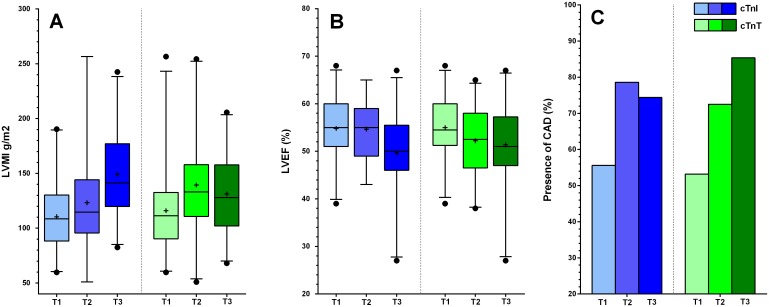
Unadjusted markers for cardiovascular disease divided per tertile of cTnI and cTnT.Box and Whisker plot of serum cTnI and cTnT concentrations divided into tertiles (T1, T2, T3) indicating the median, interquartile range, 2.5th and 97.5th percentile for unadjusted LVMI (A) and LVEF (B). The percentage of patients with significant CAD divided per tertile of serum cTnI and cTnT are shown in graph C. Serum cTnI is shown in shades of blue and serum cTnT is shown in shades of green. LVMI: Left Ventricular Mass Index; LVEF: Left Ventricular Ejection Fraction; CAD: Coronary Artery Disease.